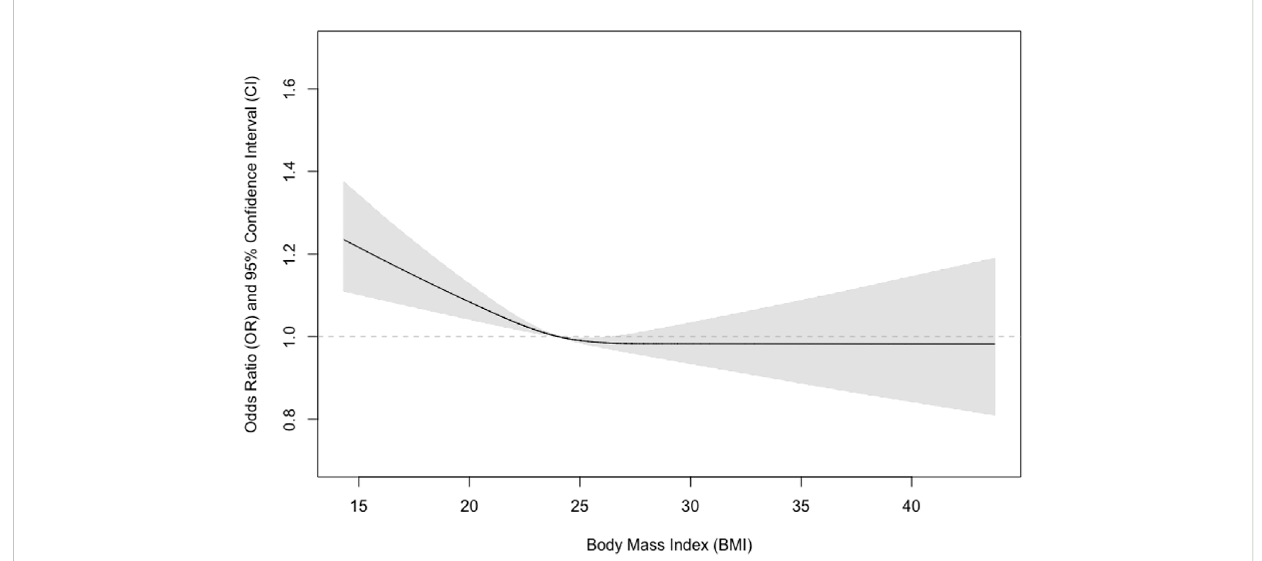
FIGURE 4 Association between body mass index and COPD in men and women.